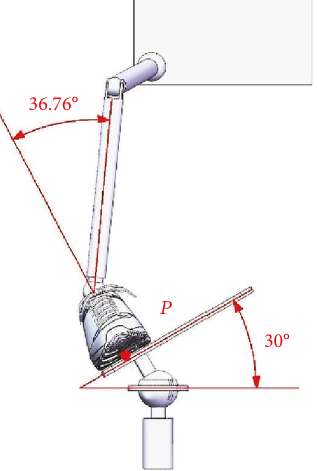
Figure 9: Limit posture of the ankle joint for the varus motion ( β max = 30 ° ).